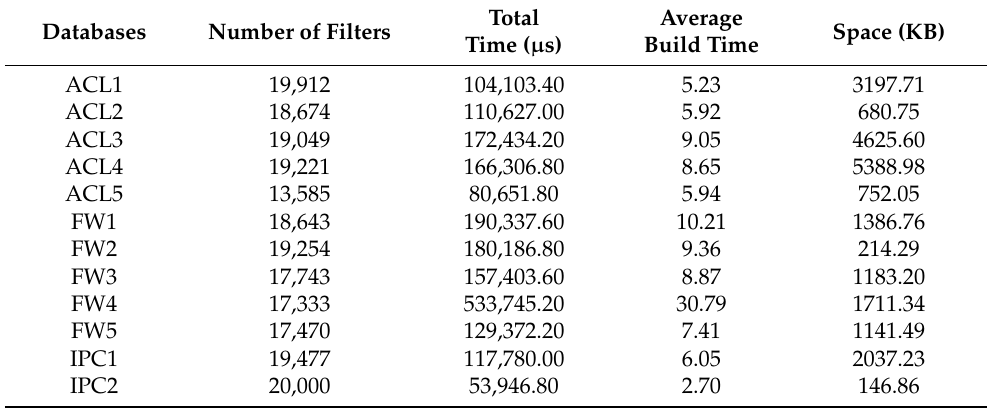
Table 14. Cost of the SBV algorithm to build auxiliary information with 20K filter databases.